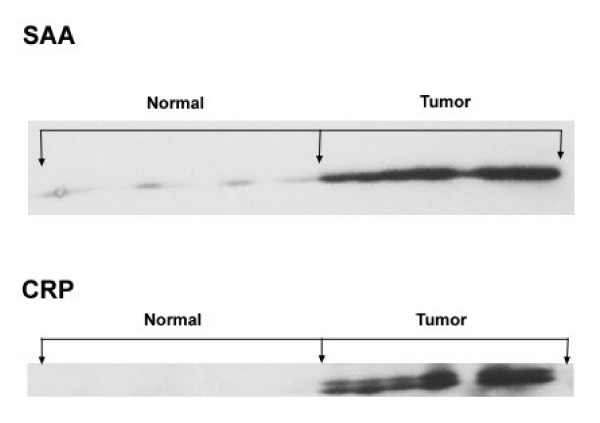
SDS-PAGE Western blot analysis of CRP and SAA. CRP and SAA levels in sera of eight lung cancer patients and eight healthy controls were analyzed. The sera chosen were those that gave extremely high or low values for the corresponding assay on the antibody microarrays.